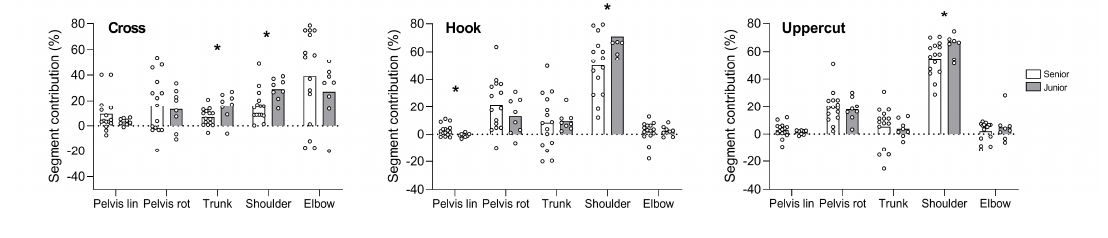
Figure 2. Segments’ translation and rotation contributions (%) for the three punching techniques for the two groups of boxers. Segments’ contributions for trunk, shoulder and elbow are a combined translation and rotation. Bars represent mean values while white points represent individual data points. * denotes a significant difference between groups ( p ≤